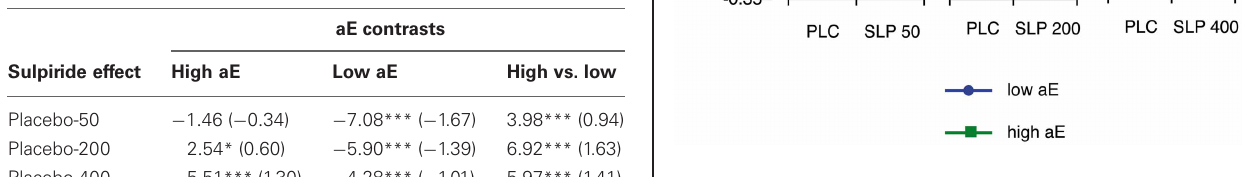
FIGURE 3 | Disordinal interactions of aE × Substance on posterior vs. anterior theta reactivity ( M and SEM values) contrasting high and low aE groups which received placebo (PLC) with each of the three different doses of sulpiride (SLP; 50, 200, or